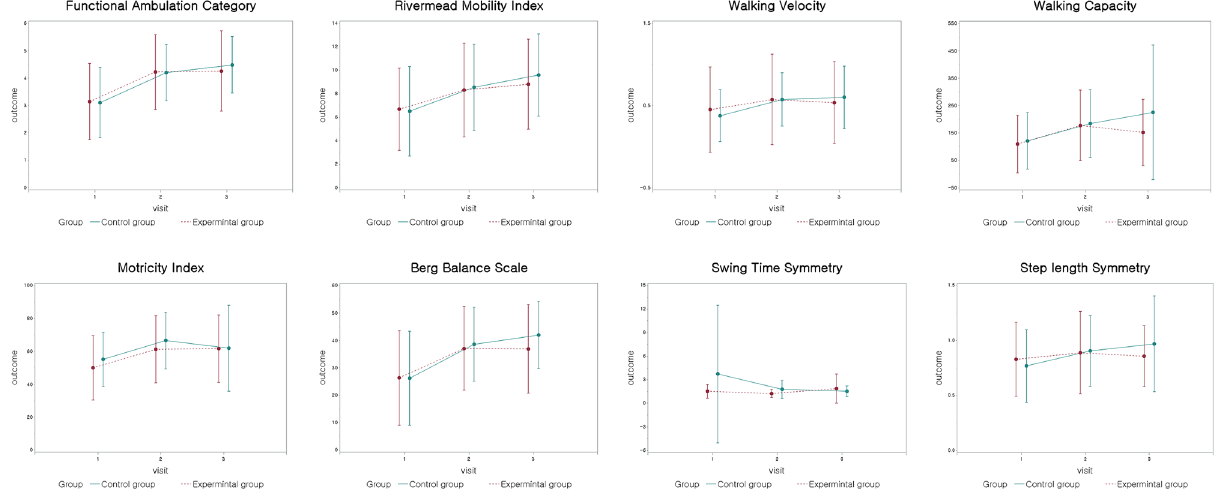
Figure 3. The changes of outcome measures pre-intervention (0 week), immediate post-intervention (4 weeks) and 4 weeks after intervention (follow up) of the control group (solid line) and experimental group (dotted